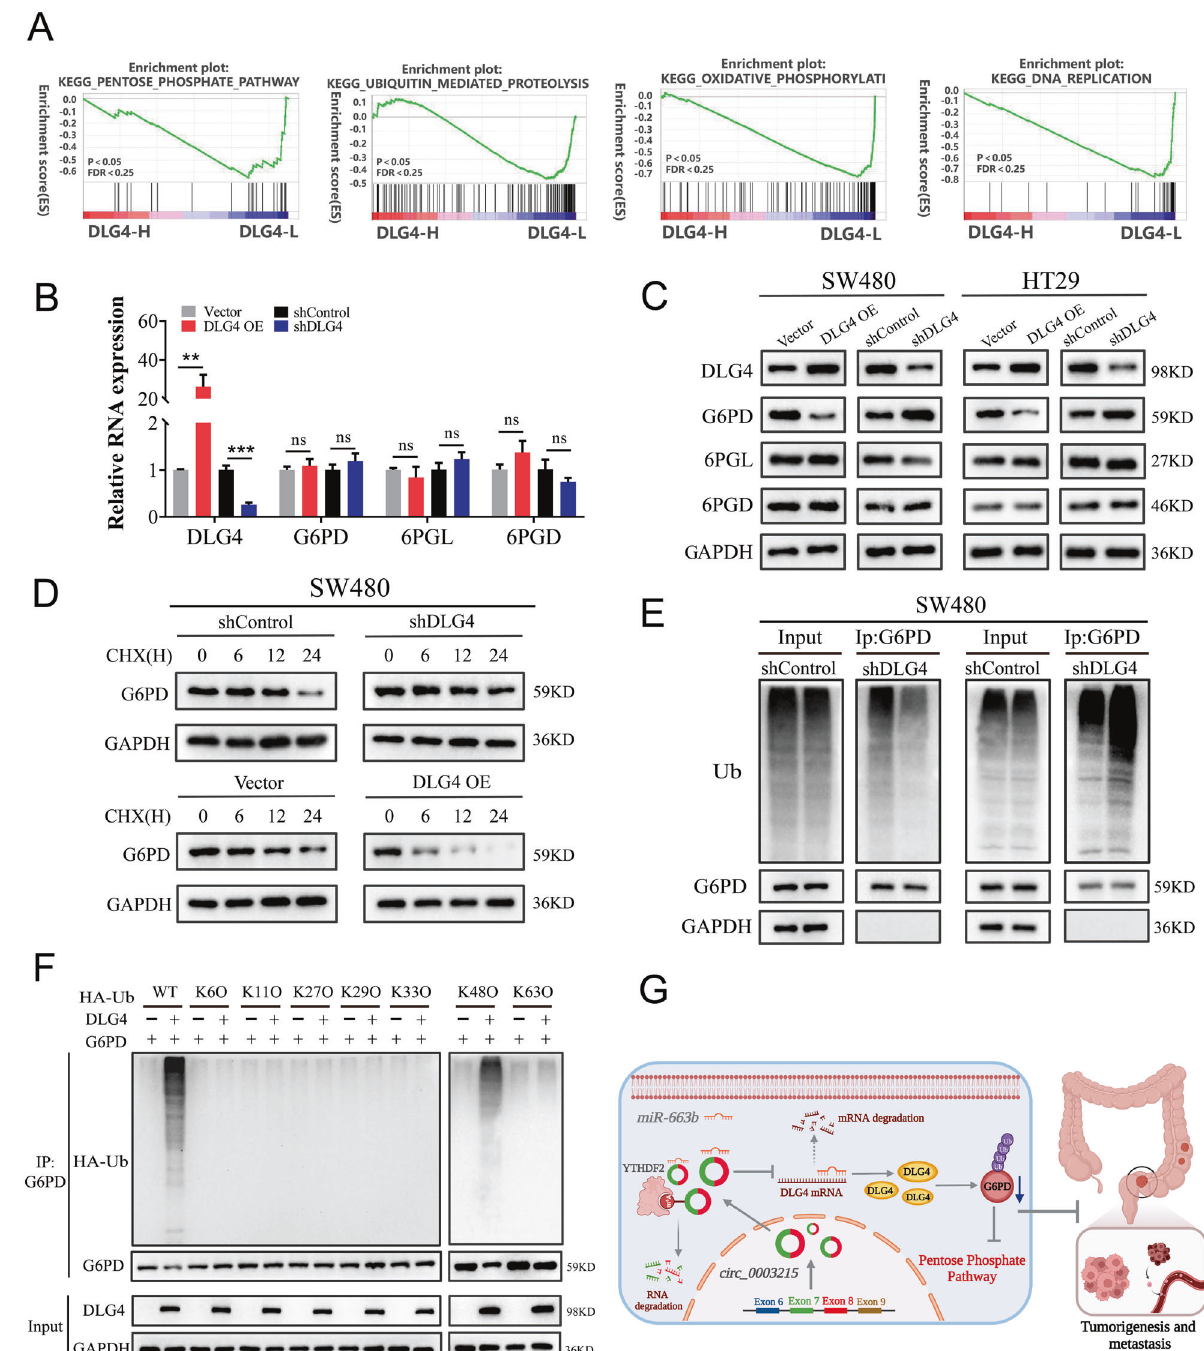
Fig. 8 DLG4 regulates PPP through the K48-linked ubiquitination of G6PD. A GSEA analysis showed that low DLG4 expression associated with pentose phosphate pathway, ubiquitin-mediated proteolysis, DNA replication and oxidative phosphorylation. B The mRNA levels of DLG4, G6PD, 6PGL and 6PGD were detected in SW480 cells using RT-qPCR, upon overexpression or knockdown of DLG4. C The expression of DLG4, G6PD, 6PGL and 6PGD proteins levels were analyzed following DLG4 knockdown and DLG4 overexpression in CRC cells. D Degradation of G6PD was investigated using western blot analysis in a CHX chase assay in SW480 cells after DLG4 overexpression or knockdown. E The immunoprecipitation / western blotting assays were used to detect the ubiquitination levels of G6PD protein in SW480 cells after overexpression or knockdown of DLG4. F DLG4 induced K48-linked ubiquitination of G6PD in HEK-293T cells. G Illustration of the mechanism of circ_0003215 on promoting CRC pathogenesis and metastasis via miR-663b/DLG4/G6PD axis-mediated pentose phosphate pathway. encoded proteins to exert their biological function [35]. Further- studied. Nuclear retained circRNAs can regulate the expression of more, it has been widely demonstrated that circRNAs can their host gene through interacting with RNA binding proteins or competitively bind to miRNAs, acting as “ molecular sponges, ” alternative splicing [34]. In addition, circRNAs contain open thereby attenuating the inhibitory effect of miRNAs on the reading frames that have been shown to be translated into the Cell Death and Disease